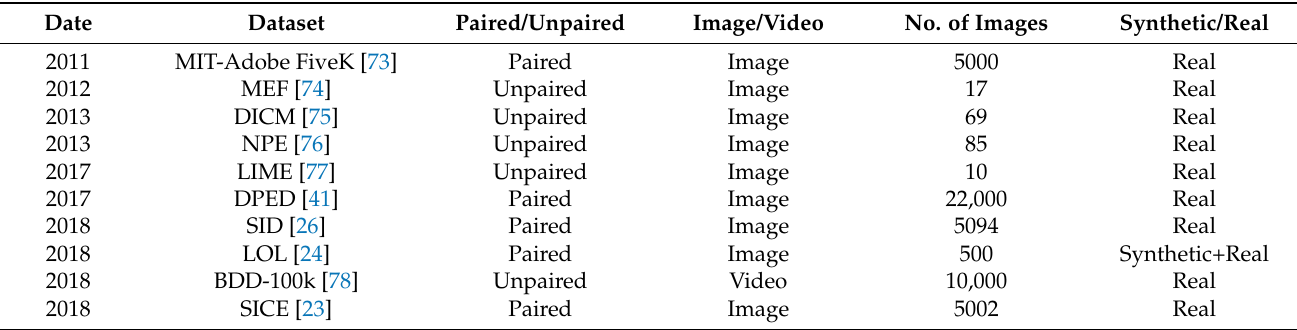
Table 2. Summary of low-illumination image